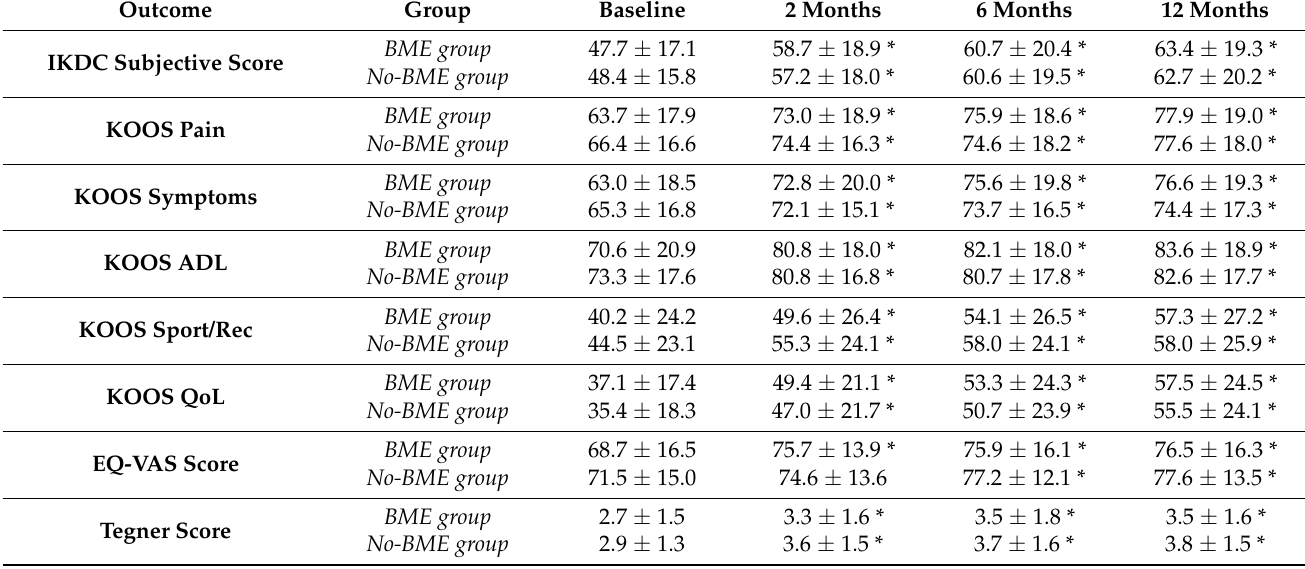
Table 2. Clinical scores during follow-up in the BME and no-BME